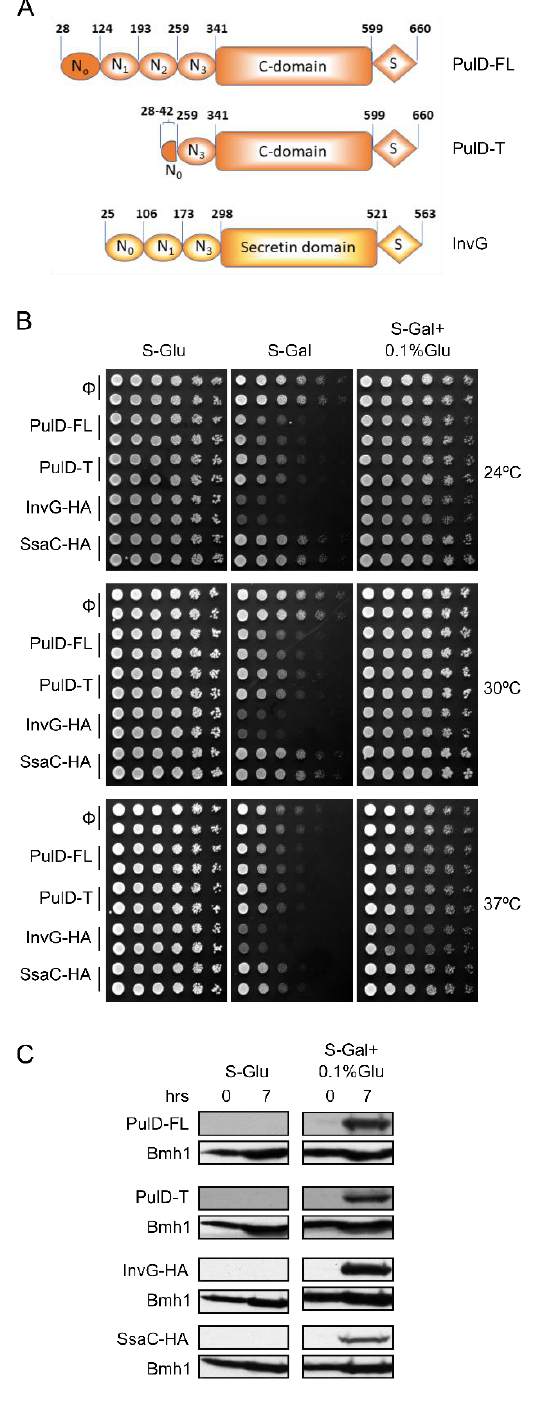
FIGURE 1: Moderate expression of secretins is not toxic to yeast